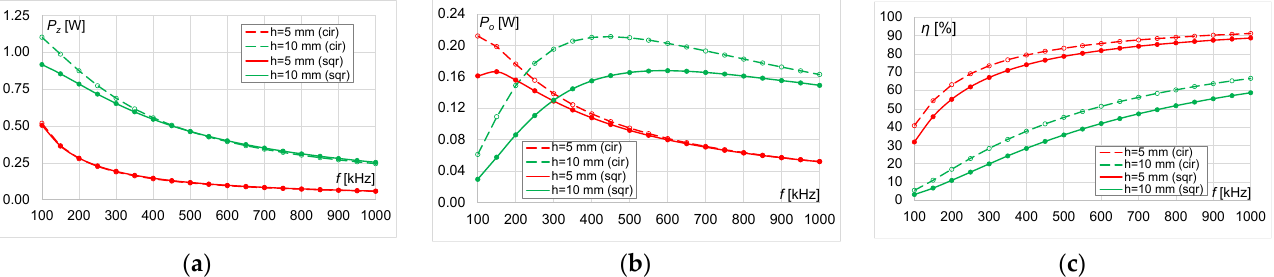
Figure 10. Results for circular and square coils with r = 10 mm and number of turns n = 35 at different distances ( h = 5 mm and h = 10 mm): ( a ) transmitter power, ( b ) receiver power and ( c ) power transfer efficiency.